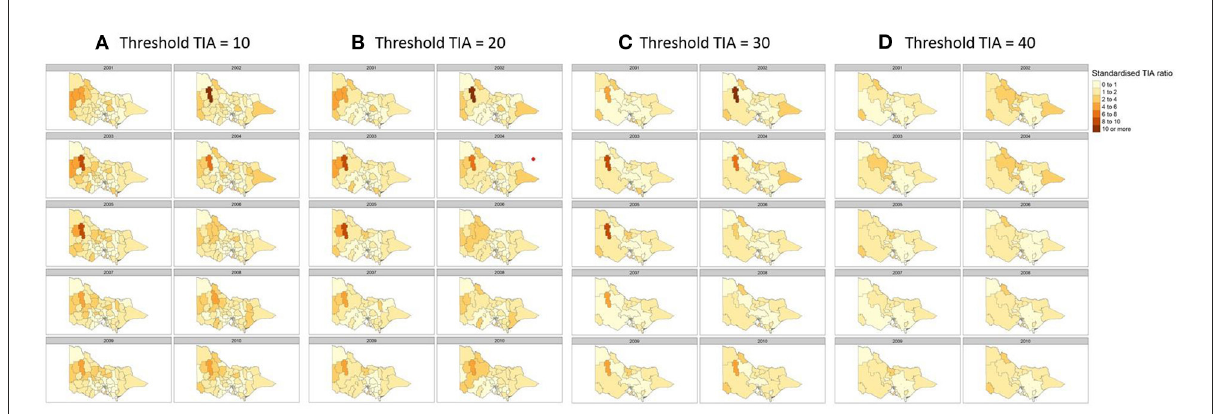
FIGURE4 Sensitivity analysis to detect changes in hot spots by merging regions with TIA count of (A) 10, (B) 20, (C) 30, and (D) 40 per year. Covariates used in the regression were hypertension, sex and population count, proportion of population above 60 and SES decile according to the Index of Relative Socioeconomic Advantage and Disadvantaged